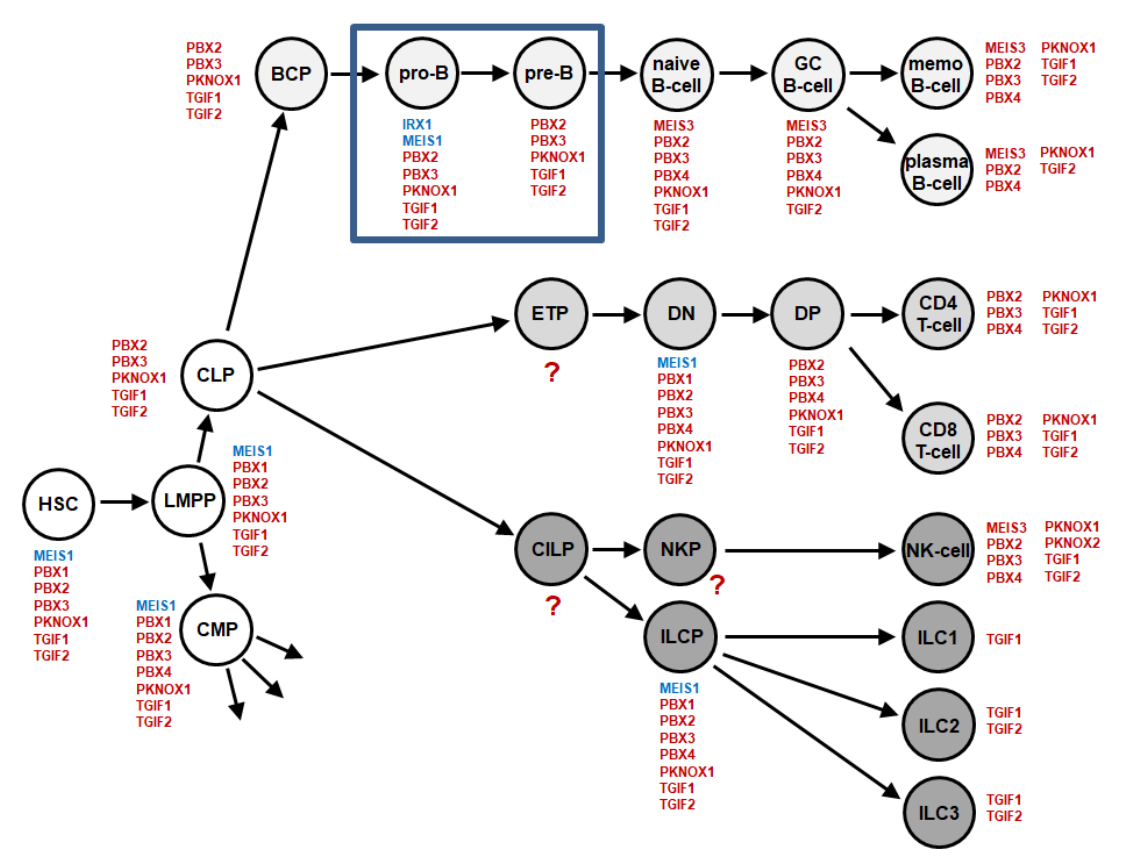
Figure 1. Extended lymphoid TALE-code. This diagram summarizes the screening results for expression analyses of TALE-class homeobox genes (red) in early hematopoiesis and lymphopoiesis. The newly analyzed stages for pro-B-cells and pre-B-cells are boxed in blue. We have termed this expression pattern lymphoid TALE-code. Expression of IRX1 and MEIS1 are highlighted in blue. Abbreviations: BCP, B-cell progenitor; CILP, common innate lymphoid progenitor; CLP, common lymphoid progenitor; CMP, common myeloid progenitor; DN, double negative; DP, double positive; ETP, early T-cell progenitor; GC, germinal center; HSC, hematopoietic stem cell; ILC, innate lymphoid cell; ILCP, innate lymphoid cell progenitor; LMPP, lymphomyelo-primed progenitor; macro, macrophage; memo B-cell, memory B-cell; NKP, NK-cell